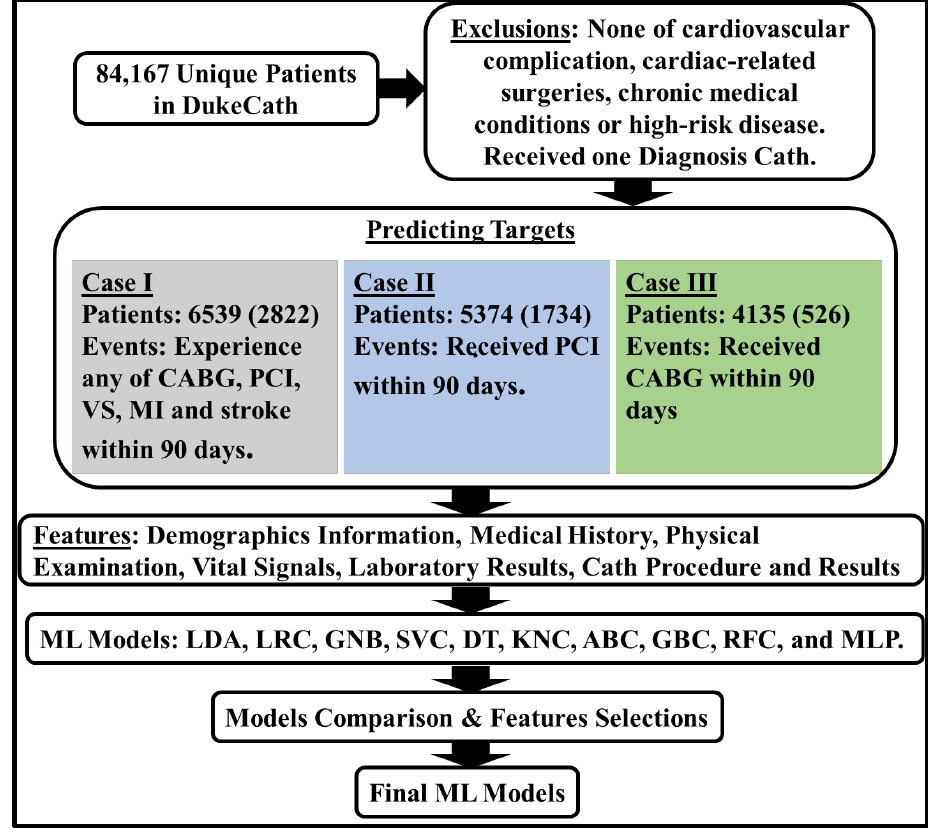
Figure 1. The flowchart of the ML applications on the DukeCath data set.